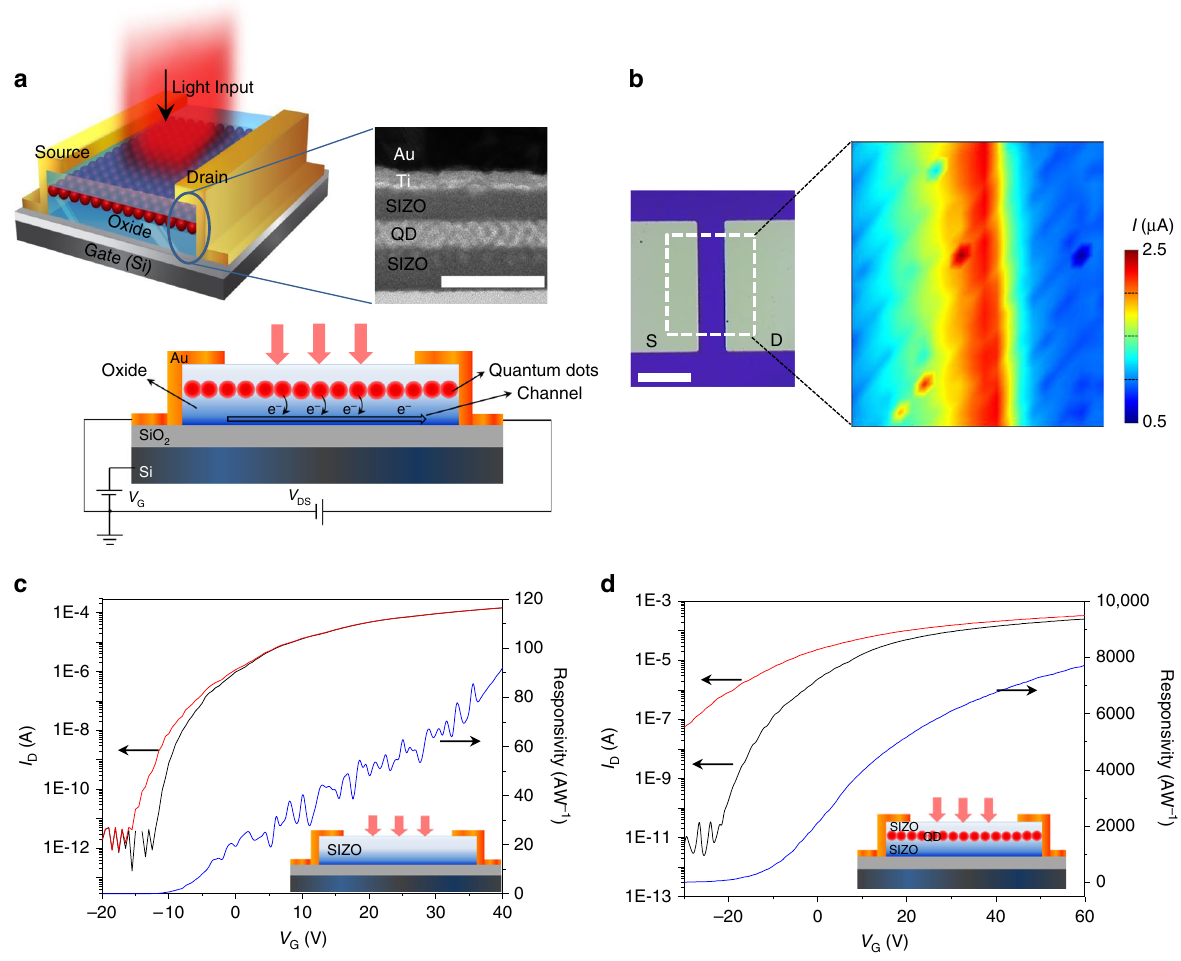
Fig. 1 Hybrid phototransistors of quantum dots buried in amorphous-oxide semiconductors. a Schematics of proposed device structure. The channel contains OQO layers, with QDs buried between the top and bottom oxide (SIZO) layers, as shown in the cross-sectional TEM image. Scale bar is 100 nm. The top and bottom SIZO layer thicknesses are 30 and 40 nm, respectively. The 1 – 6 QD layers have 5.5 – 30-nm thicknesses. The photocarriers generated by the QDs via light absorption are transported through the oxide layers. b Spatial photocurrent pro fi le for 487-nm laser beam with 10-nW power. Scale bar is 100 nm. The photocurrent was measured during laser beam scanning across the photodetector surface. c , d Photocurrent response and R of ( c ) SIZO- only device and ( d ) monolayered-red-QD (1RQ) OQO device, at 487-nm illumination wavelength with 10-nW power. V SD is 5 V. Black and red lines are dark current and photocurrent, respectively. Responsivities are indicated by blue